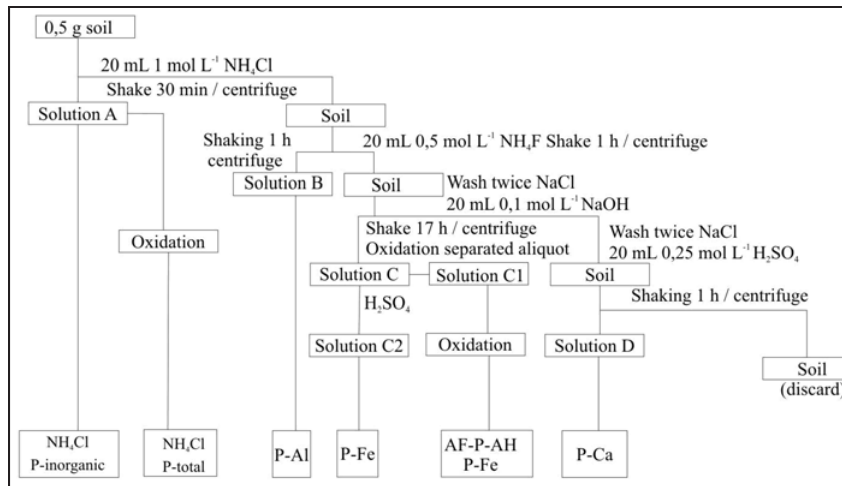
Figure 2. P fractionation diagram (adapted from Kelly et al.,